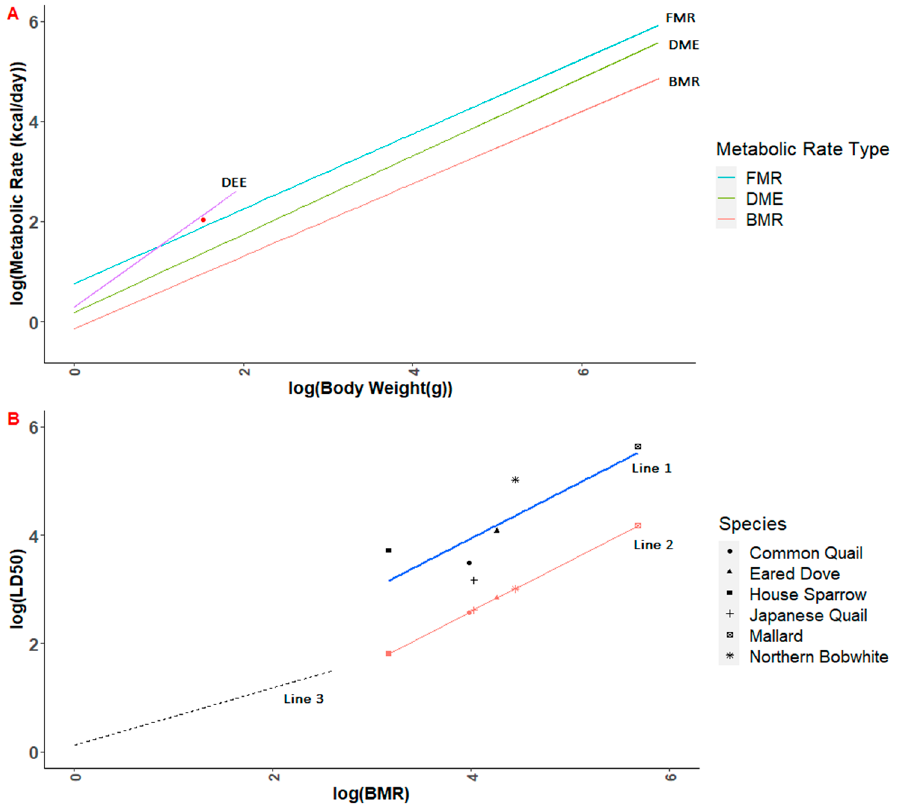
Figure 1. ( A ) shows the log–log relationship between metabolic rates used in the terrestrial investigation model (TIM) for basal metabolic rate (BMR), daily metabolized energy (DME), and field metabolic rate (FMR) as well as daily energy expenditure (DEE) for simulated body weight ranges for the ruby-throated hummingbird ( Archilochus colubris ). Powers and Nagy [15] detail a mean metabolic rate for the Anna’s hummingbird ( Calypte anna ), plotted here against the DEE. DEE is calculated using the relationship log(DEE) = 1.72 + 1.21 ∗ log(mass), from [72] BMR, DME, and FMR are calculated using standard allometric relationships between body weight and energetic requirements, detailed in the TIM Ver. 3.0 guidance, Appendix F [34]. ( B ) shows the log–log relationship of reported and estimated LD50s for imidacloprid and BMRs for several species and ruby-throated hummingbird. Line 1 (blue) corresponds to the fitted linear regression between reported LD50s for 6 species and their estimated BMR, using Equations (5) and (7). Line 2 (red) is the estimated LD50s using the fitted regression coefficients in Equation (6). Line 3 (purple) represents the estimated LD50 for hummingbirds across the range of body weights for US hummingbird species using slope and intercept values from [72] with regression coefficients derived from the fitted regression from Equation (7).